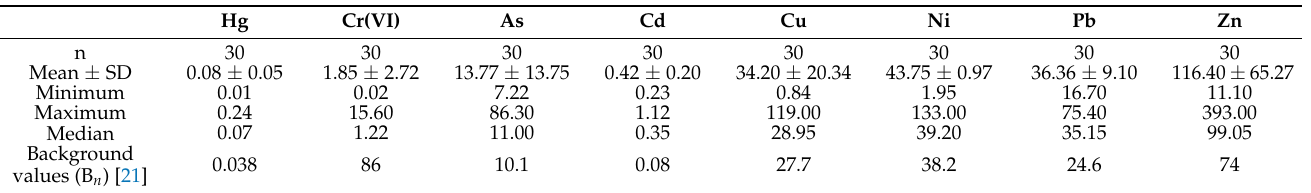
Table 4. Sedimentary characteristics and concentrations of heavy metals in surface sediments of Taihu Lake (mg · kg − 1